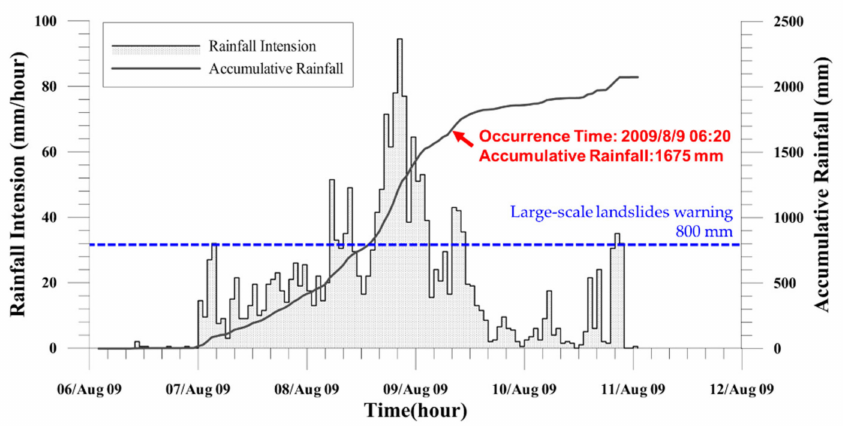
Figure 14. Effectiveness review of large-scale landslide pre-warning with historical